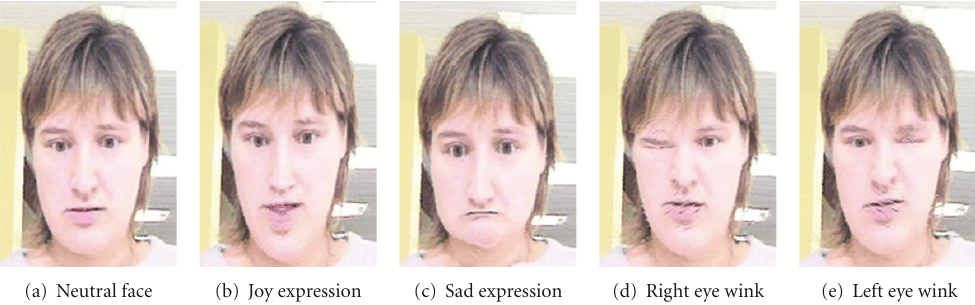
Figure 13: Selected frames from an animated face with various